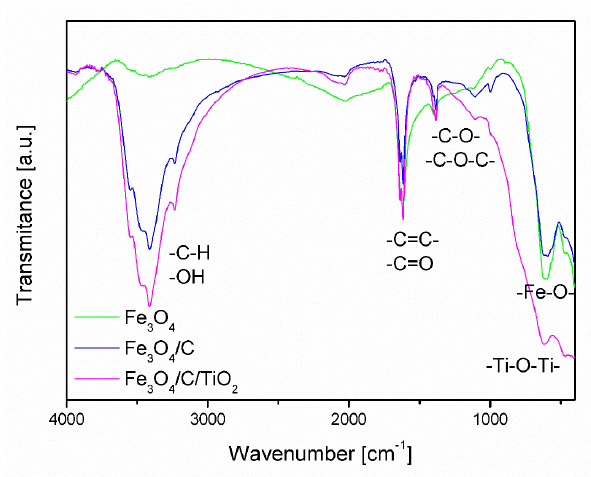
Figure 3. FT-IR spectra of Fe 3 O 4 , Fe 3 O 4 /C, and Fe 3 O 4 /C/TiO 2 .